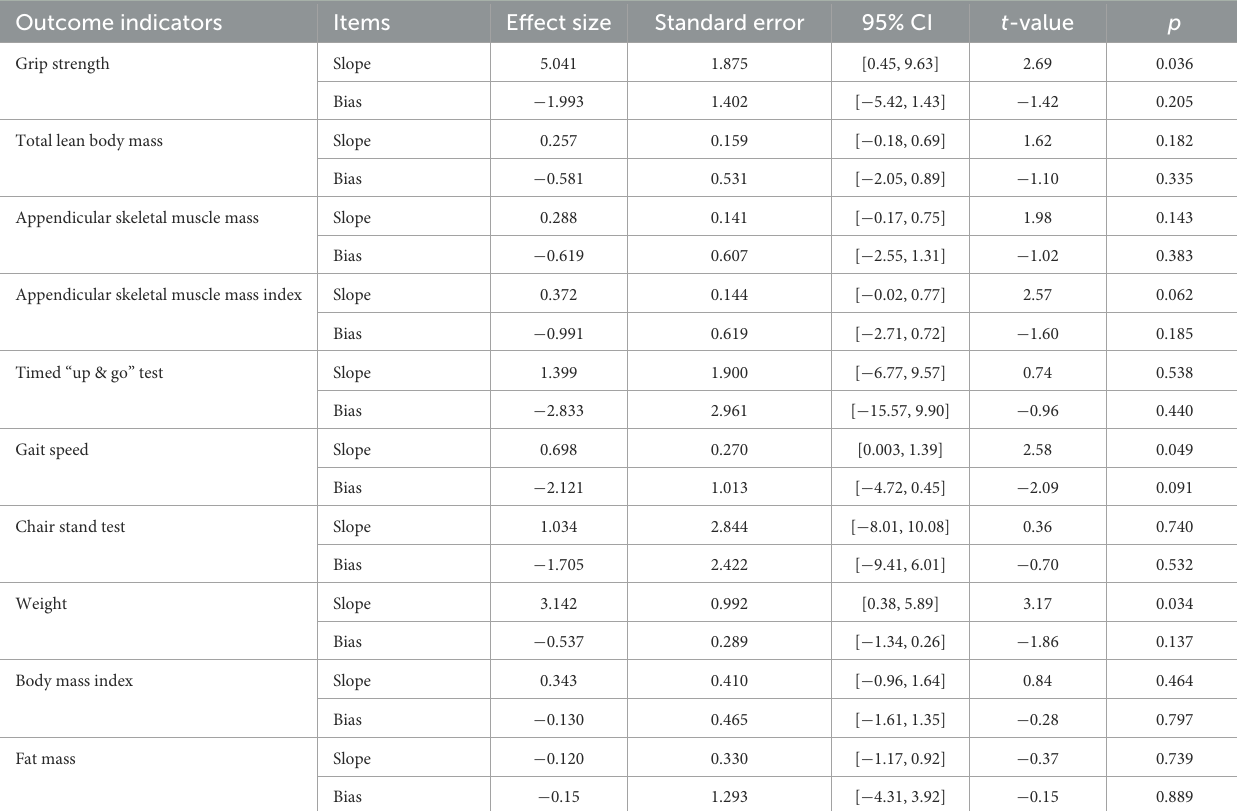
TABLE 2 Egger’s test results of publication